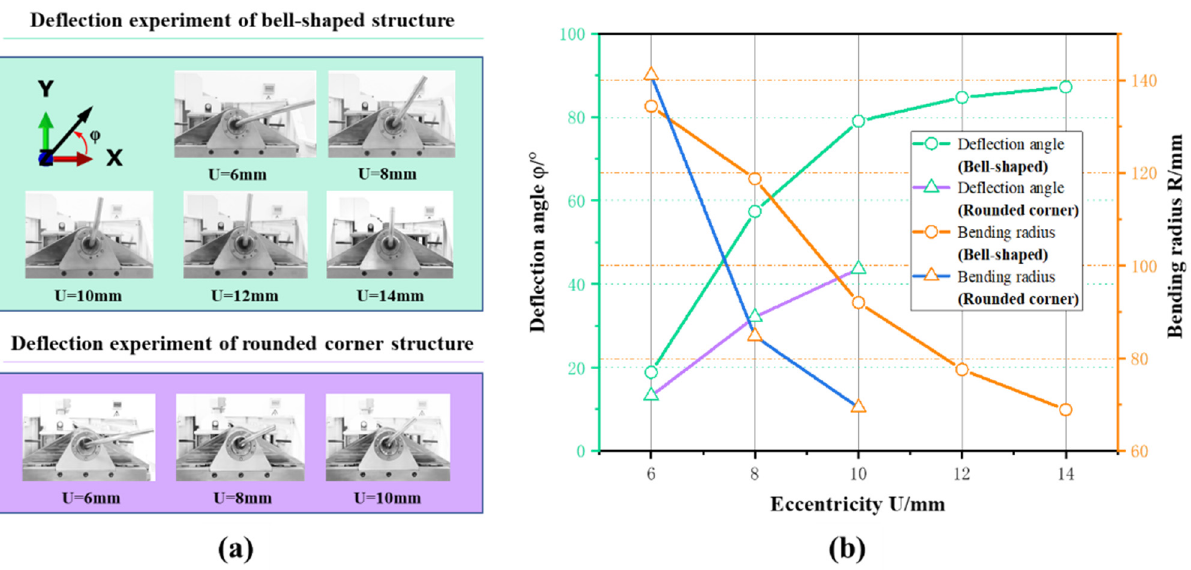
Figure 16. Active deflection forming experiment: ( a ) experimental processes of active deflection; ( b ) bending radius and deflection angle distribution.